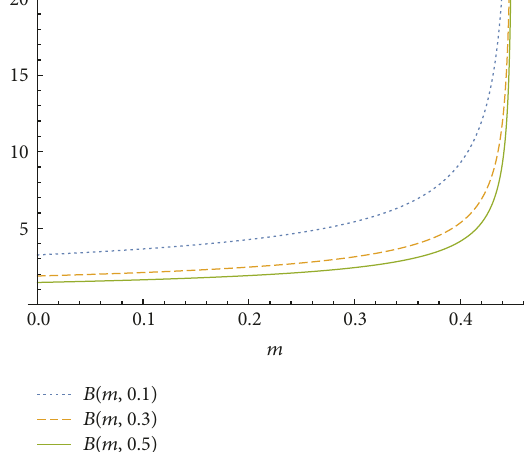
Figure 4: Coefficient 𝐵(𝑚,𝛽) (40) of solution (4) as function of 𝑚 for 𝛽 = 0.1, 0.3, 0.5 .